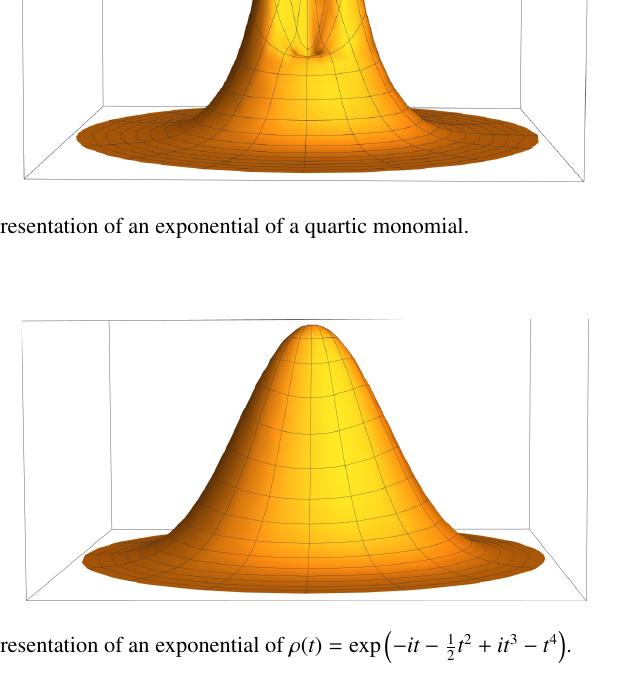
Figure 3. Positive representation of an exponential of ρ ( t ) = exp